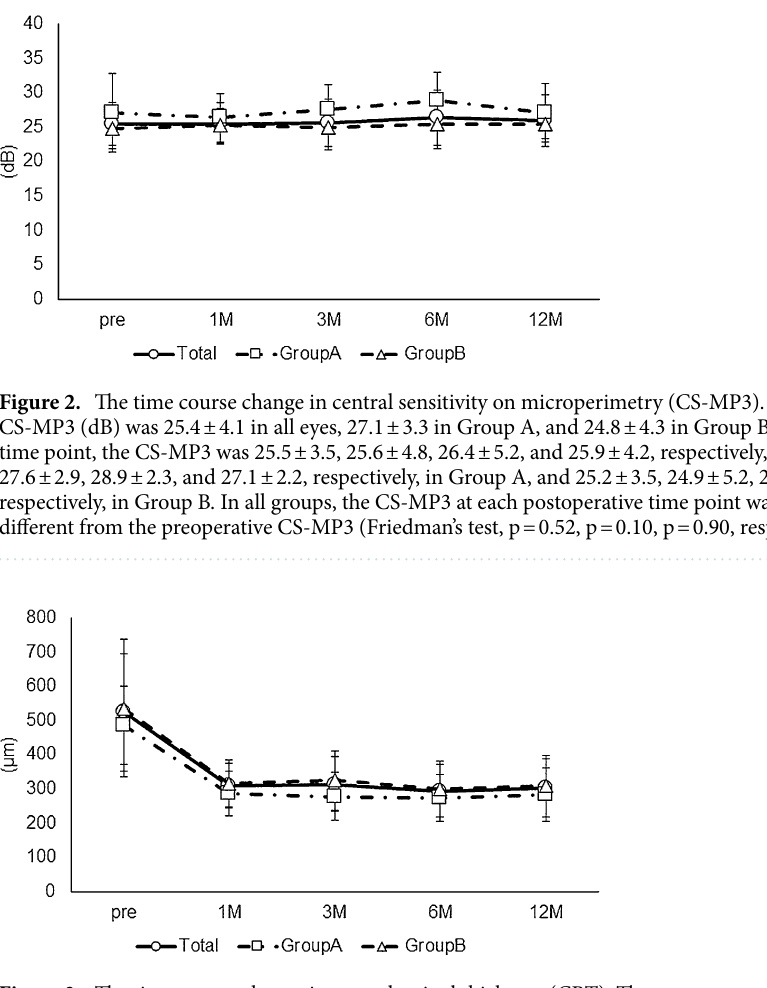
Figure 3. The time course change in central retinal thickness (CRT). The mean preoperative CRT (μm) was 524.2 ± 114.8 in all eyes, 486.4 ± 63.7 in Group A, and 535.4 ± 125.3 in Group B. At each postoperative time point, the CRT was 309.6 ± 65.5, 314.6 ± 66.2, 293.8 ± 52.2, and 303.7 ± 80.1, respectively, in all eyes, and 286.2 ± 57.6, 278.9 ± 23.5, 274.4 ± 17.0, and 284.2 ± 36.1, respectively, in Group A, and 316.4 ± 67.6, 325.2 ± 71.4, 299.5 ± 57.8, and 309.4 ± 89.1, respectively, in Group B. In all groups, the CRT at each postoperative time point was statistically better than the preoperative CRT ( Friedman’s test, p < 0.01, p = 0.03, p < 0.01; post hoc analysis, p < 0.01, p < 0.01, p < 0.01 at all the time points, respectively).